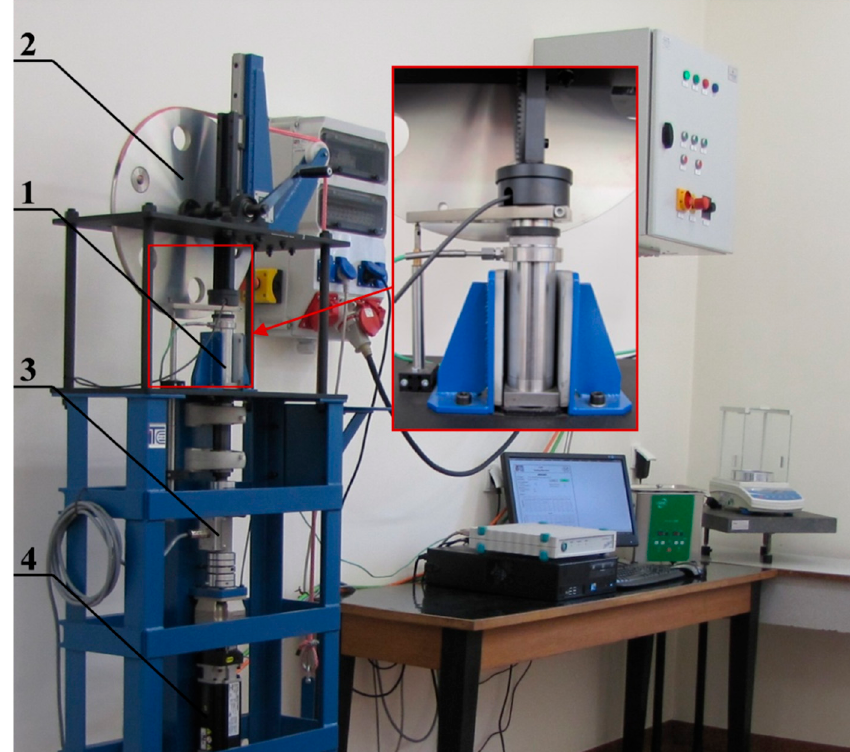
Figure 5. The testing device designed and constructed by the Institute for Sustainable Technology in Radom with cylindrical attrition tribotester (1), loading pulley (2), load and torque indicators (3) and drive (4).